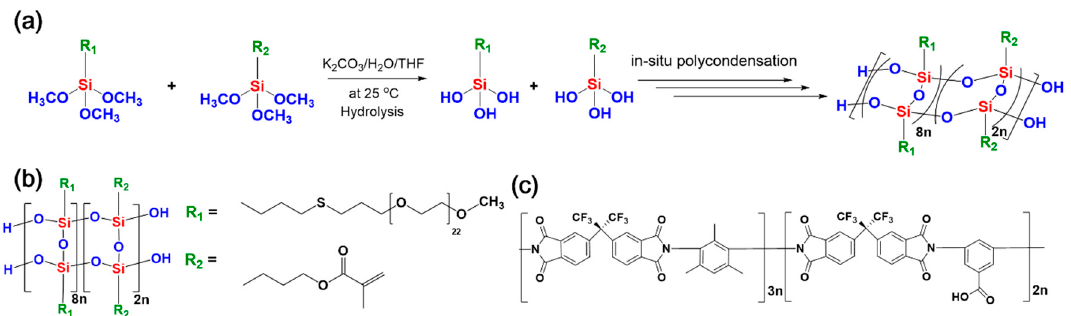
Table 1. Molecular weight and molecular weight distributions for selected materials.